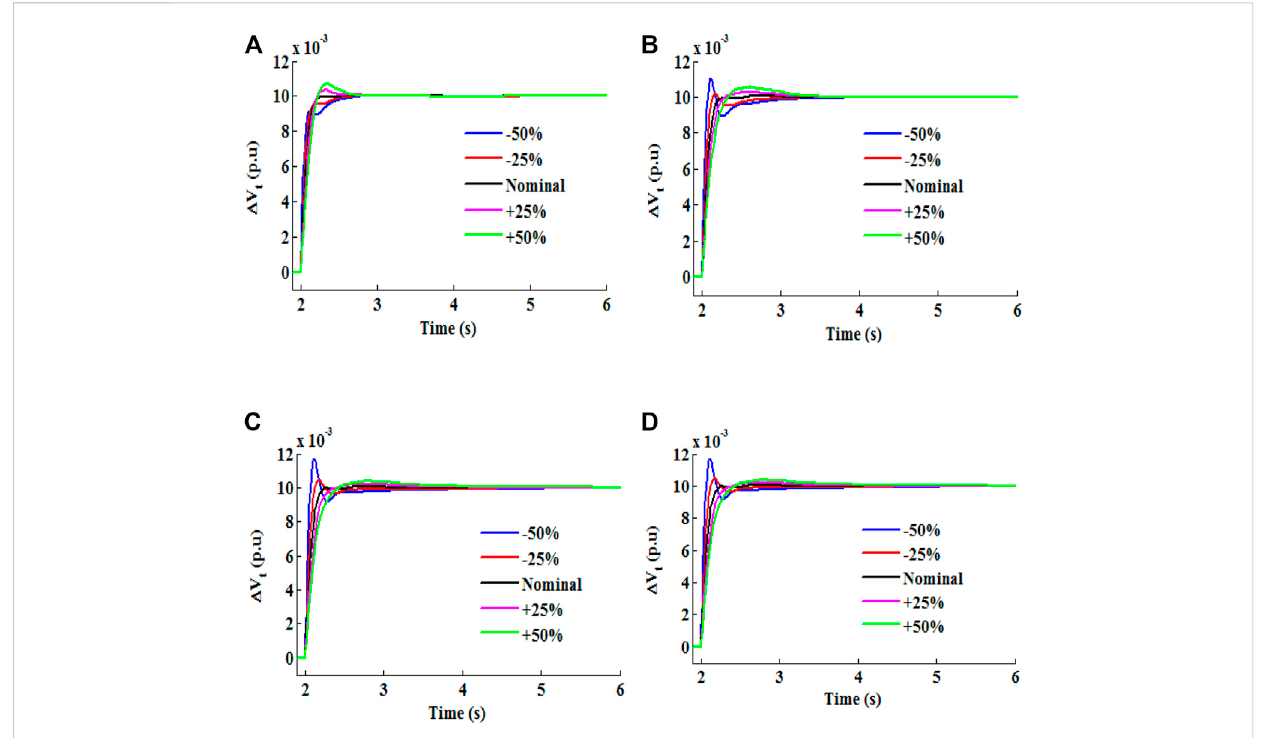
Algorithm 1:. Overall form of the MFO algorithm (Mirjalili, 2015).